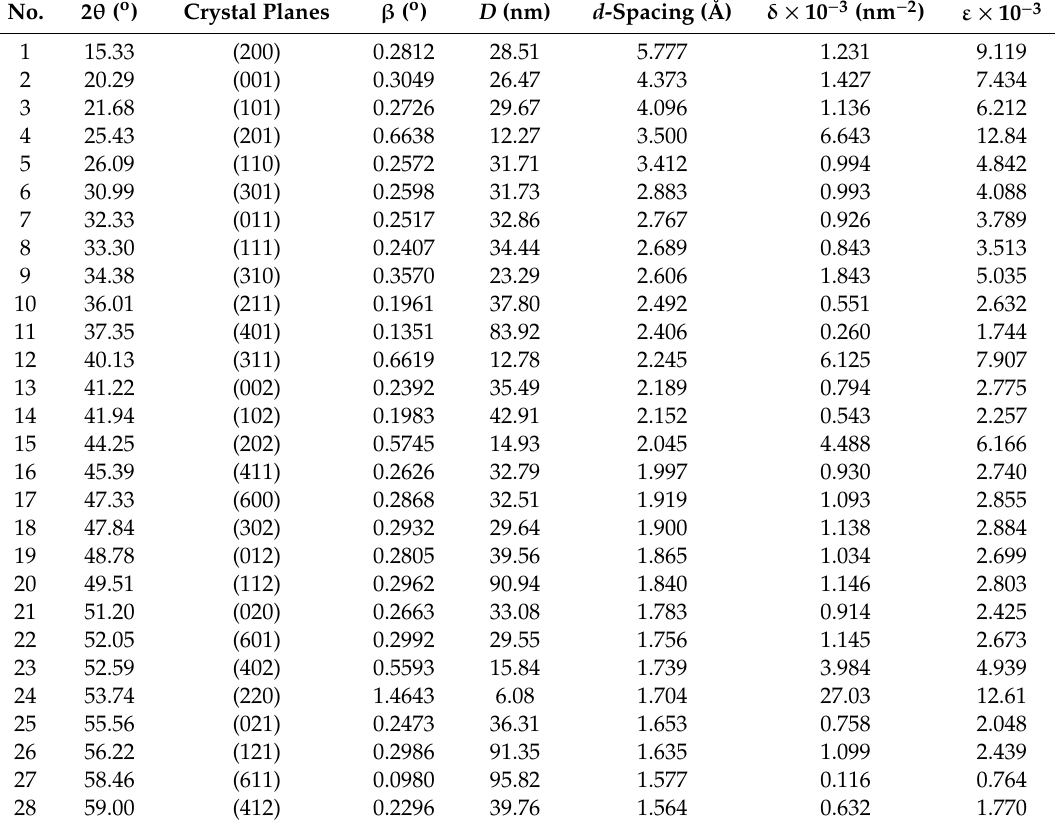
Table 1. The grain sizes, d -spacing, dislocation density and micro strain of nanosized V 2 O 5 . calculated from the XRD